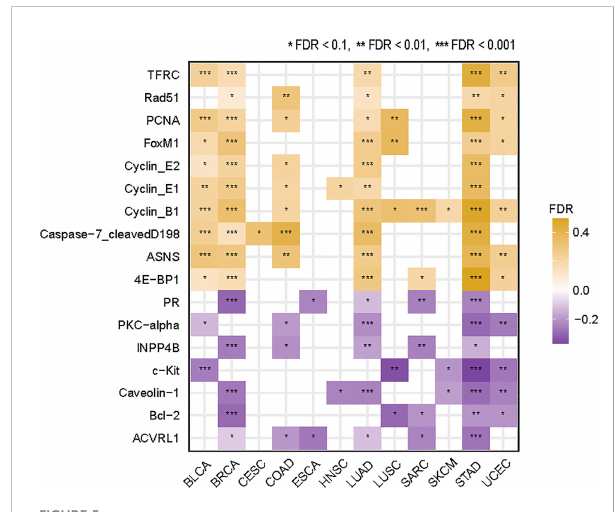
FIGURE 5 Proteins whose expression levels have signi fi cant correlations with TMB in at least fi ve cancer types. The Spearman ’ s correlation test FDR and correlation coef fi cients ( r ) are indicated.